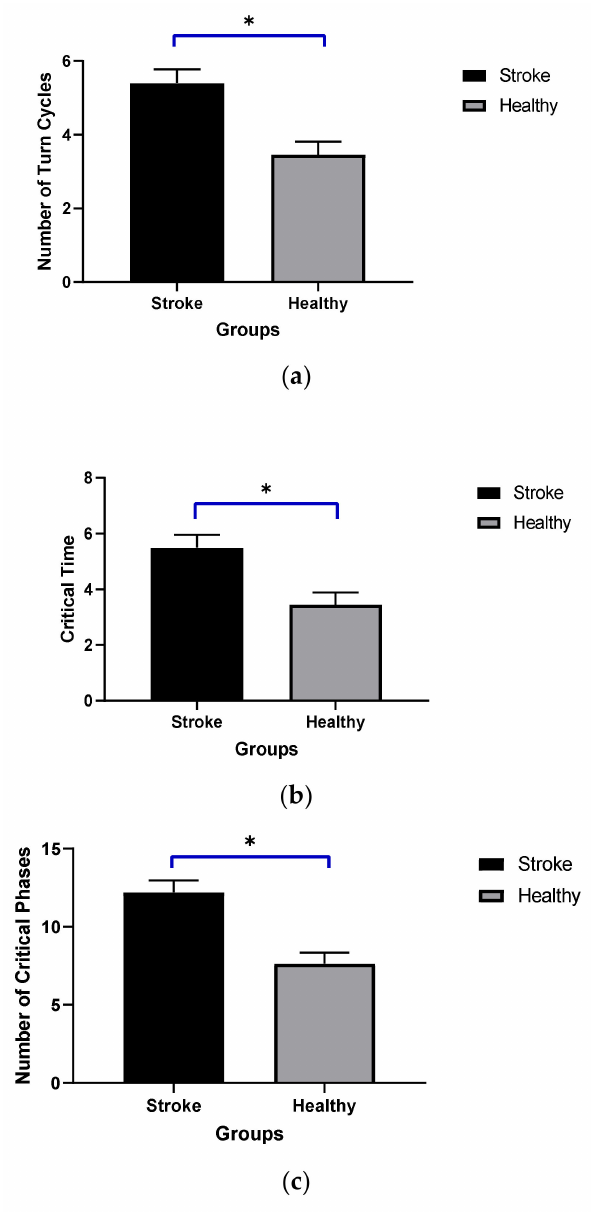
Figure 5. ( a ) Average number of turn cycles in stroke and healthy groups. ( b ) Critical time in seconds in stroke and healthy adults. ( c ) Number of critical phases during 360 ◦ turn in stroke and healthy adults. Where * represents significant different among